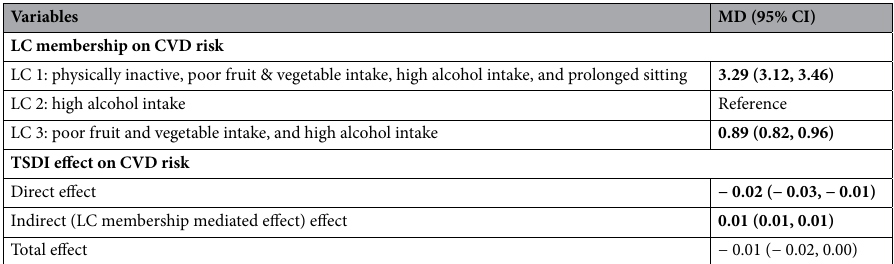
Variables MD (95% CI) LC membership on CVD